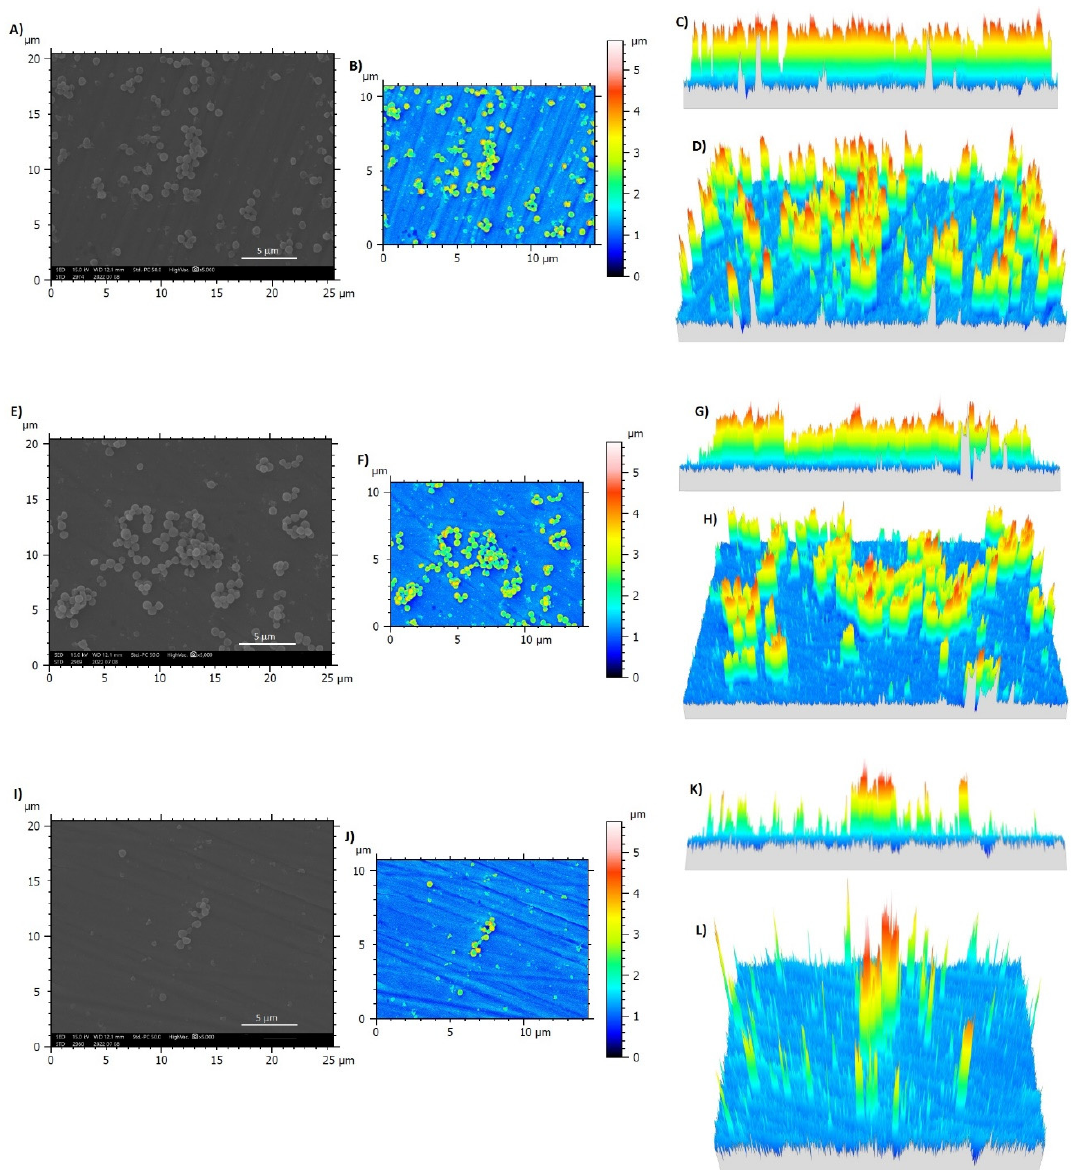
Figure 11. Three-dimensional reconstructed images of bacterial microcolonies on samples’ surfaces extracted from SEM images with SMILE VIEW TM software. Ti64ELI-MP: ( A ) SEM image at magnification 2000× (scale bar= 5 µm); ( B ) reconstructed 3D image extracted from ( A ); ( C ) cross- section image of the bacterial microcolonies on the sample surface; ( D ) whole view of bacterial microcolonies from the selected section; Ti64ELI-MP nisin pH 3: ( E ) SEM image at magnification 2000× (scale bar= 5 µm); ( F ) reconstructed 3D image extracted from ( E ); ( G ) cross-section of the bacterial microcolonies on the sample surface; ( H ) whole view of bacterial microcolonies from the selected section; Ti64ELI-MP nisin pH 6: ( I ) SEM image at magnification 2000× (scale bar= 5 µm); ( J ) reconstructed 3D image extracted from ( I ); ( K ) cross-section of the bacterial microcolonies on the sample surface; ( L ) whole view of bacterial microcolonies from the selected section. Bars indicate the height of microcolonies (µm).